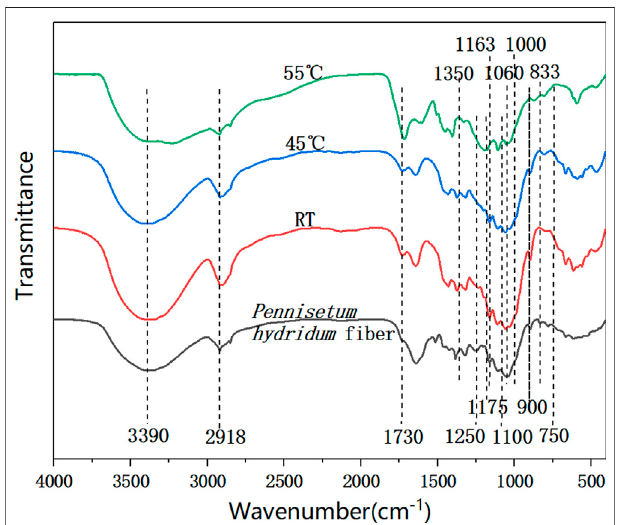
FIGURE 5 | FTIR spectra of the deligni fi ed Pennisetum hydridum fi ber and CNC prepared at different temperatures: (A) Pennisetum hydridum fi ber;